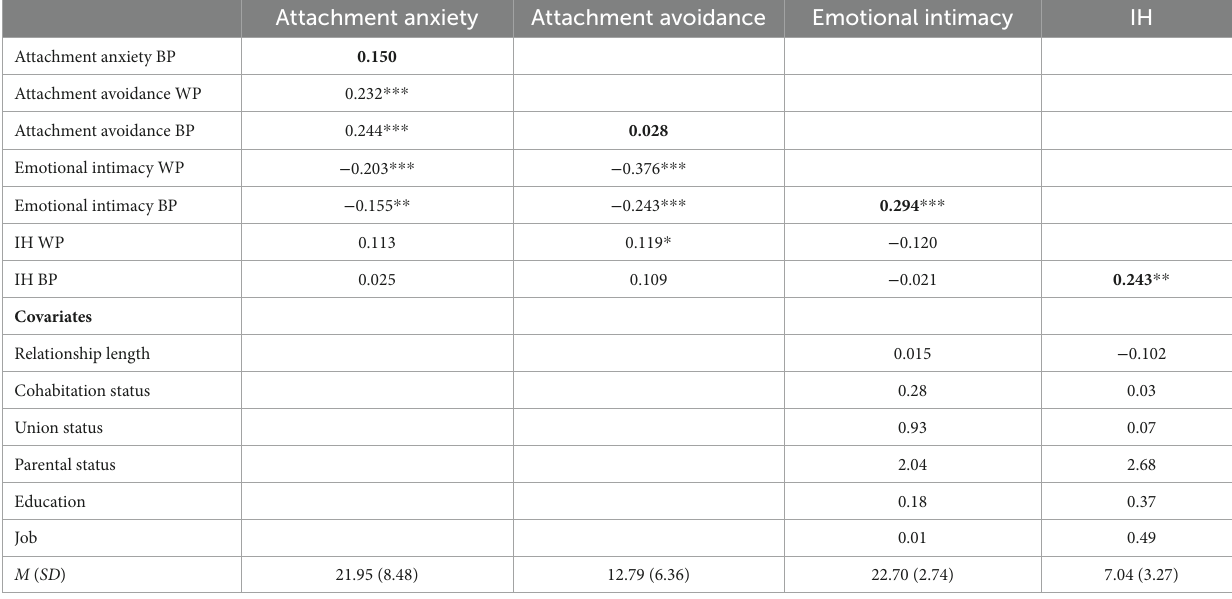
TABLE 1 Within- and between-partner correlations, covariate testing, and descriptive statistics.